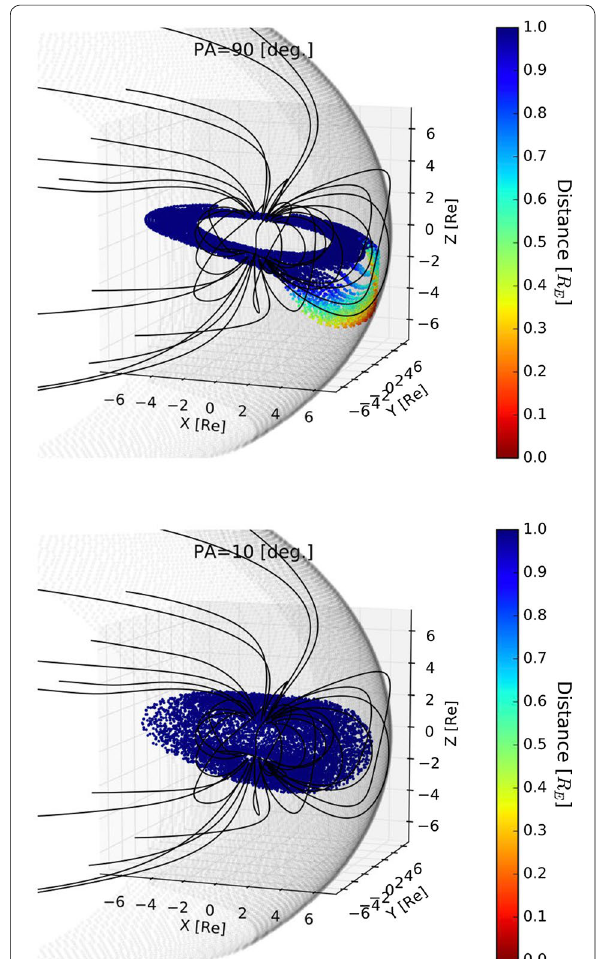
Fig. 1 Guiding center positions of 1 MeV electrons with pitch angle 90° (top panel) and 10° (bottom panel) in the geomagnetic field. Solid lines and gray circles show magnetic field lines and magnetopause boundary, respectively. Colored solid circles show the trajectories of 32 test electrons which are plotted every 5 s for 30 min. The colors indicate the minimum distance between the electron and the mag‑ netopause